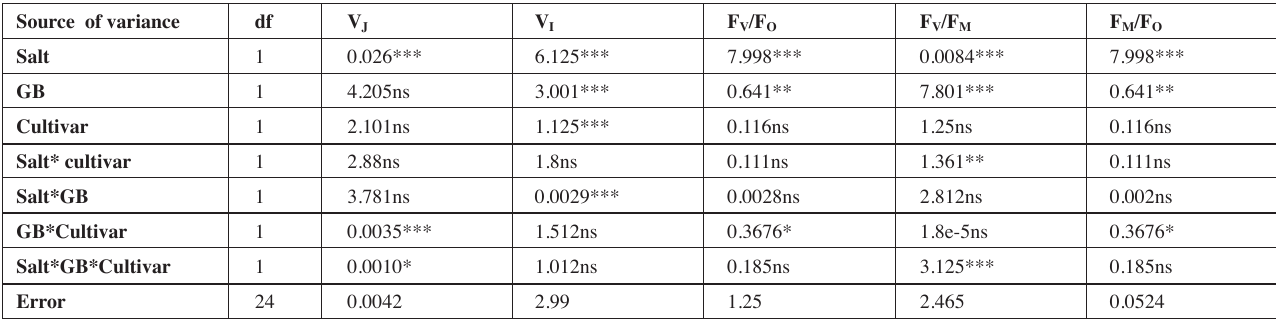
V J, = relative variable fluorescence at phase J of fluorescence transient curve, V I = relative variable fluorescence at phase I of fluorescence transient curve, F V /F O = maximum primary yield of photochemistry, F V /F M = maximum yield of photochemistry of PSII.